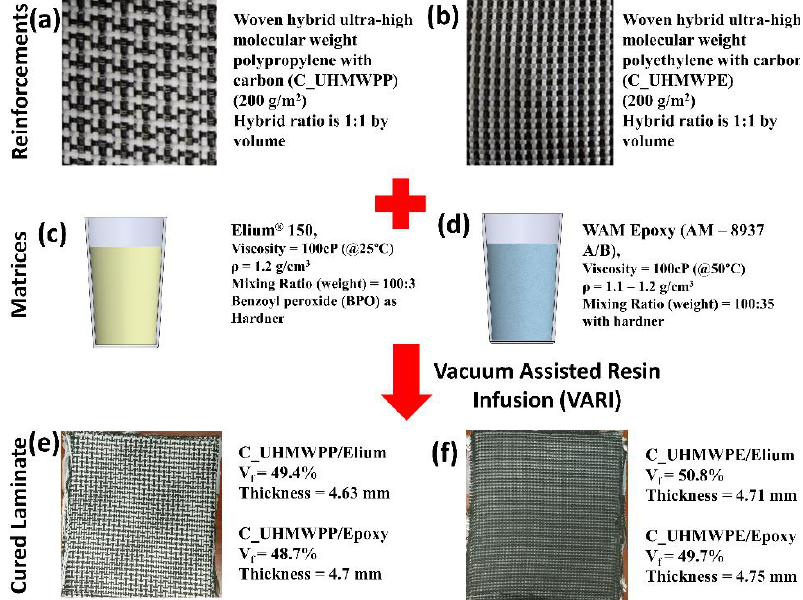
Figure 1. Properties of different fibers, resin system and laminates ( a , b ) C_UHMWPP and C_UHMWPE reinforcement system ( c , d ) Elium 150 and Epoxy matrix system ( e , f ) C_UHMWPP/Elium and C_UHMWPE/Elium cured laminates